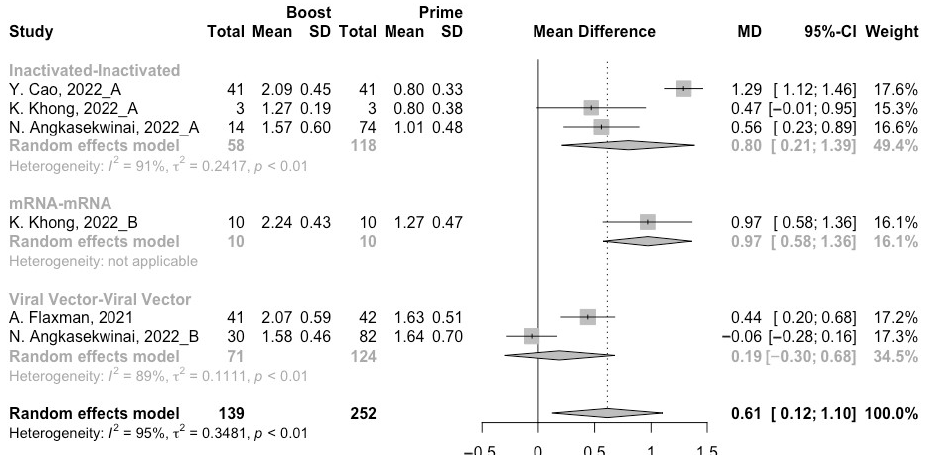
Figure 7. Forest plot of the pooled log-transformed neutralization titers against the Delta variant before and after homologous booster vaccination.